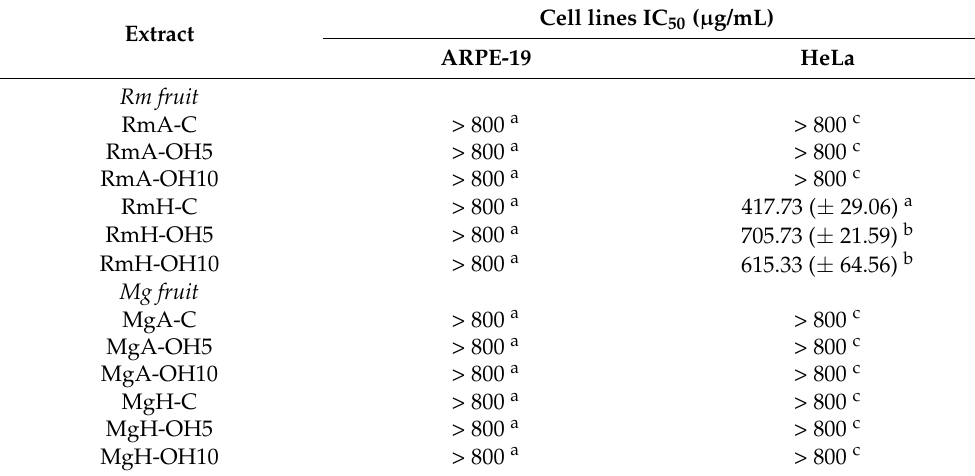
Table 6. Antiproliferative activity of R. microphylla (Rm) and M. geometrizans (Mg) fruit extracts obtained by conventional agitation (C) and ohmic heating (OH) in ARPE-19 and HeLa cell lines.